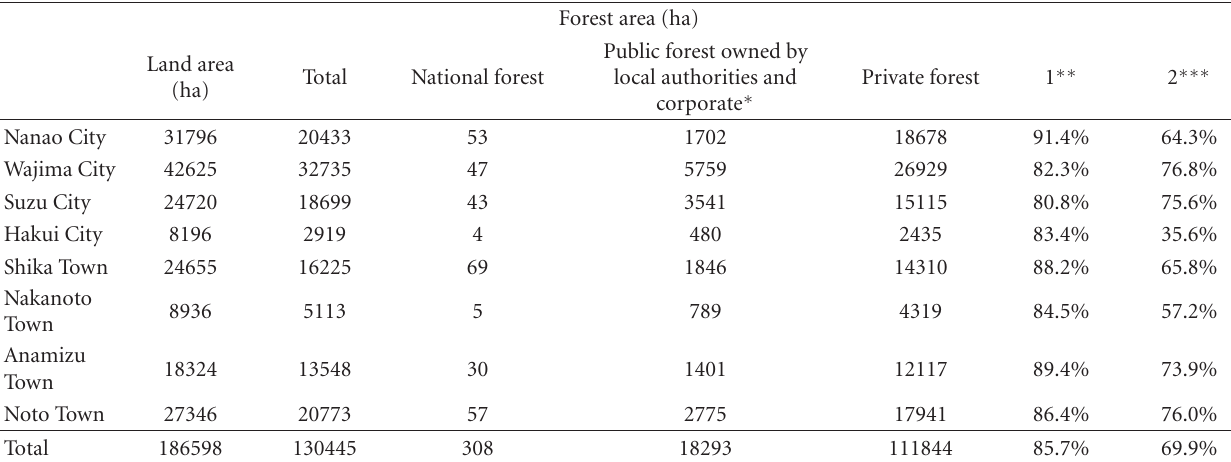
Table 9: Forest area by ownership in the Noto Region. Forest area (ha)